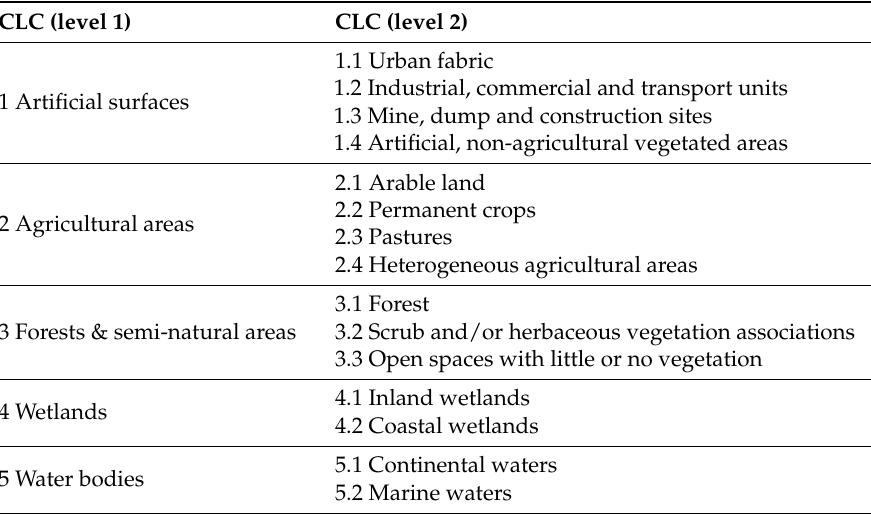
Table 1. Corine Land Cover classification (level 1 and level